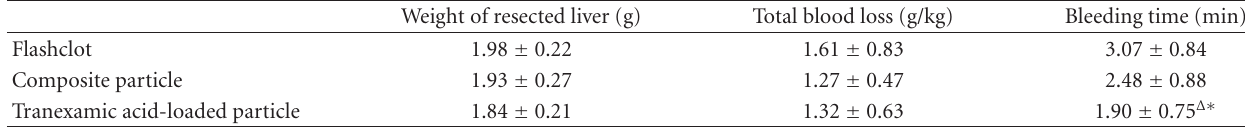
Table 1: The hemostatic e ffi ciency of several materials for the hepatic hemorrhage model of rabbits.